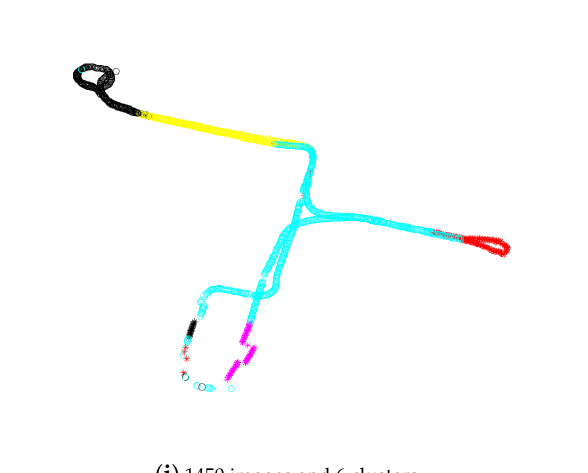
Figure 13. Maps obtained during the process using HOG y = 2.25, Ω = 1.7 with INNOVA dataset. The subfigures show different steps of the process. In the end, the process detects 6 nodes and the final average silhouette is 0.3973. The pairs of c , d , f , g show how the node merging process